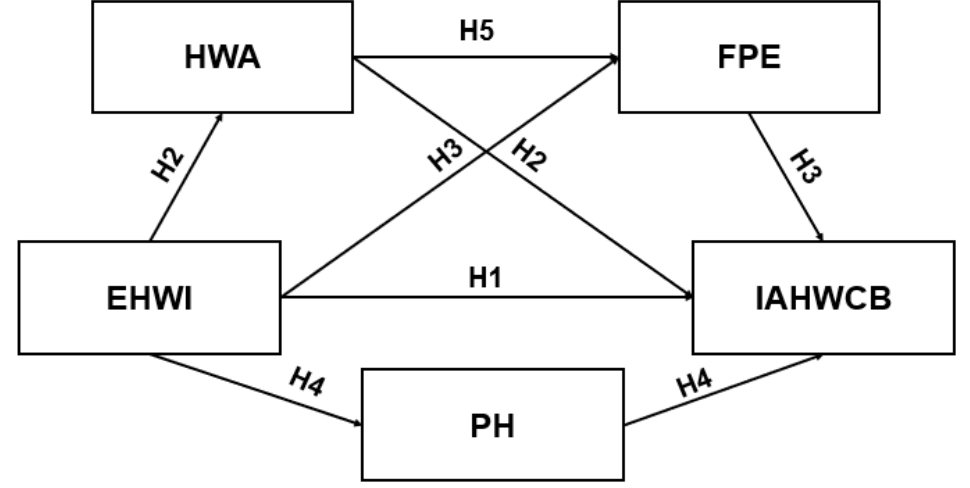
Figure 1. A model of predictors of intention to acquire healthy weight-control behaviors.